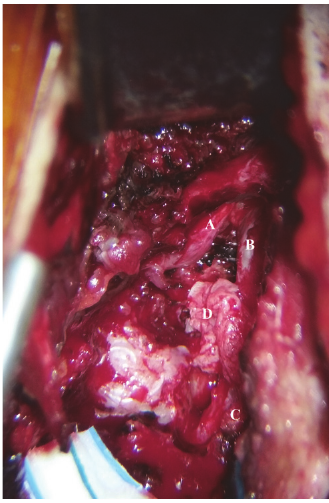
in left flexion of the hip and numbness on the anterior aspect of the left thigh.